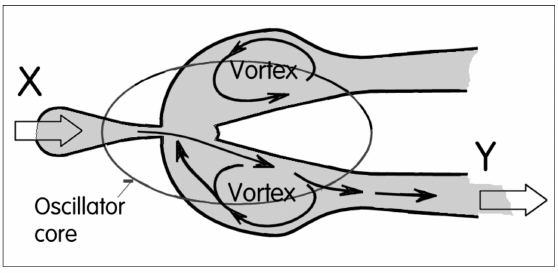
Figure 20. In an attempt at increasing the frequency of generated oscillation, the feedback loops were here reduced to the “islandless” spaces for stationary (“captive”) vortices. The feedback path is shortest, but without solid guidance by walls (which are here too far from the deflected jet flowpath), there is an opportunity for non-reliability. Small versions (millimetre size) of this oscillator type can reach a frequency range with the top limit at ≈ 500